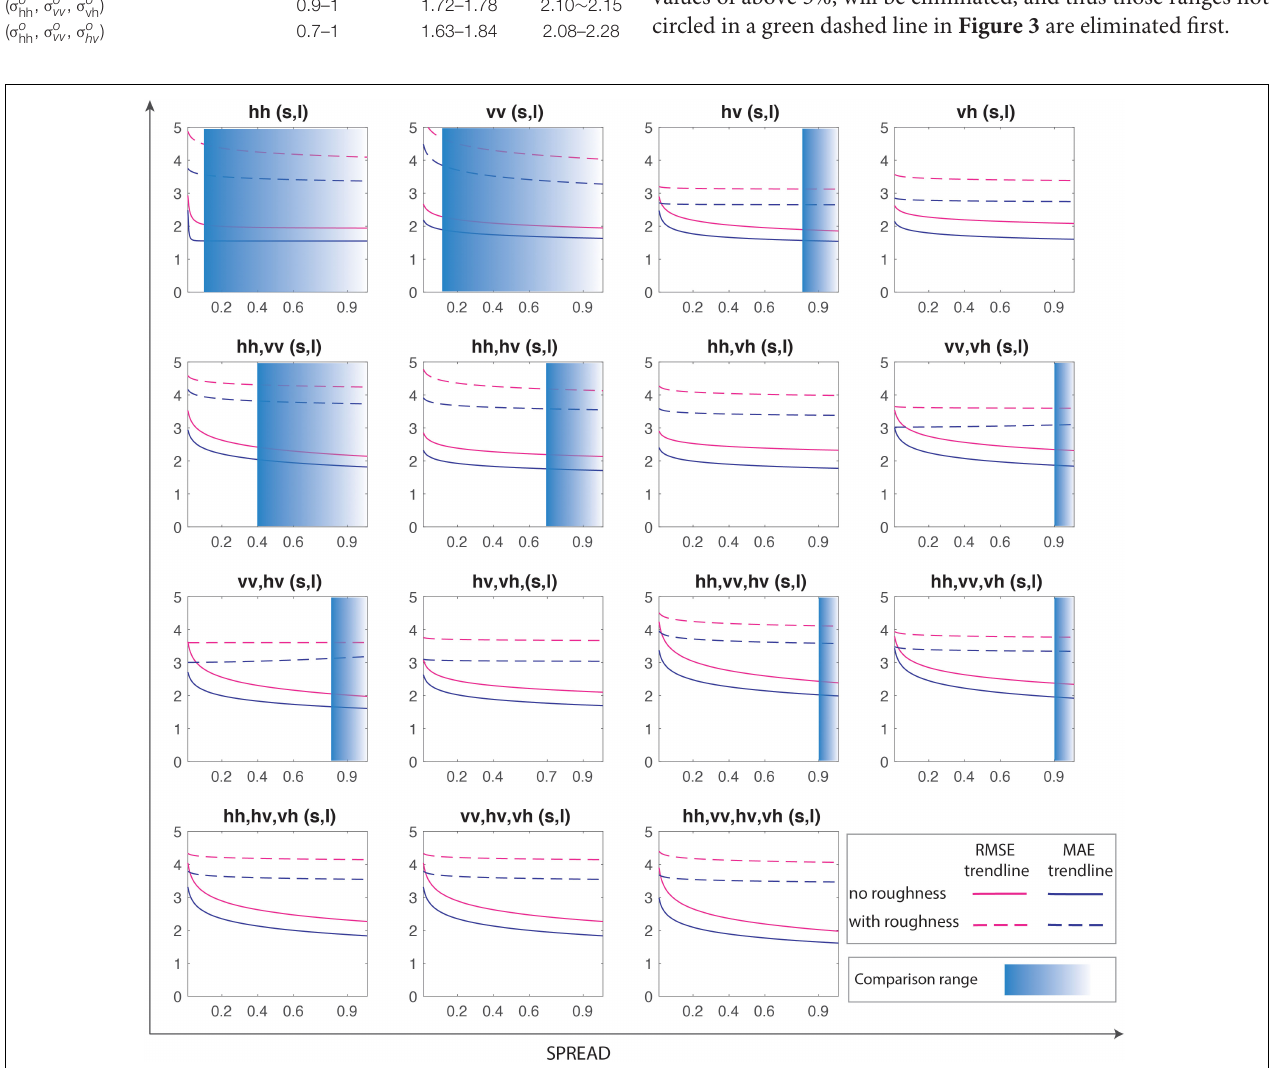
FIGURE 5 | Comparison of trends of models’ final performance metrics by independent test between backscatter-BSSM and backscatter-roughness-BSSM models constructed by GRNN. The blue translucent ranges of the spread parameter are within those recommended ranges.